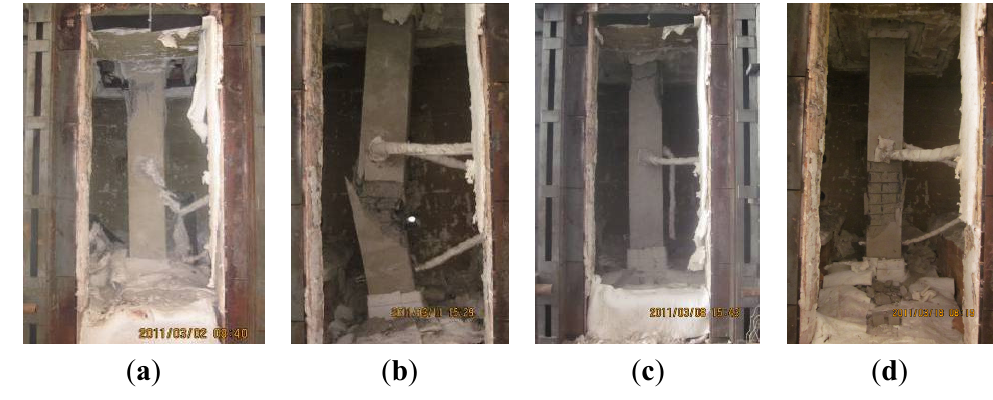
Figure 11. Global failure modes of specimens ( a ) NCC-1; ( b ) NCC-2; ( c ) RCC-1; and